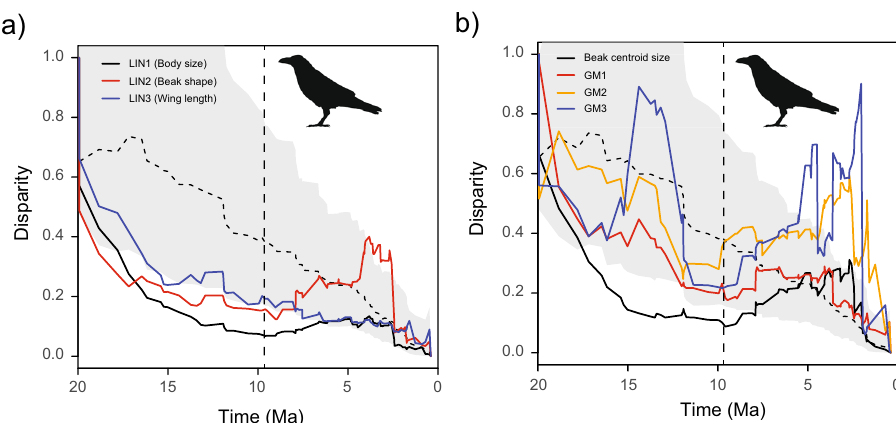
Fig. 4 Evolution of phenotypic disparity in Corvidae. Mean subclade disparity through time (DTT) for a linear measurements and b beak shape obtained through geometric morphometrics. Dashed lines indicate median subclade DTT based on 1000 simulations of character evolution under a Brownian motion model with a single tree-wide rate of change. Grey shaded areas depict 95% credible intervals for DTT estimated in simulation. Vertical dashed lines indicate the onset of diversi fi cation of the genus